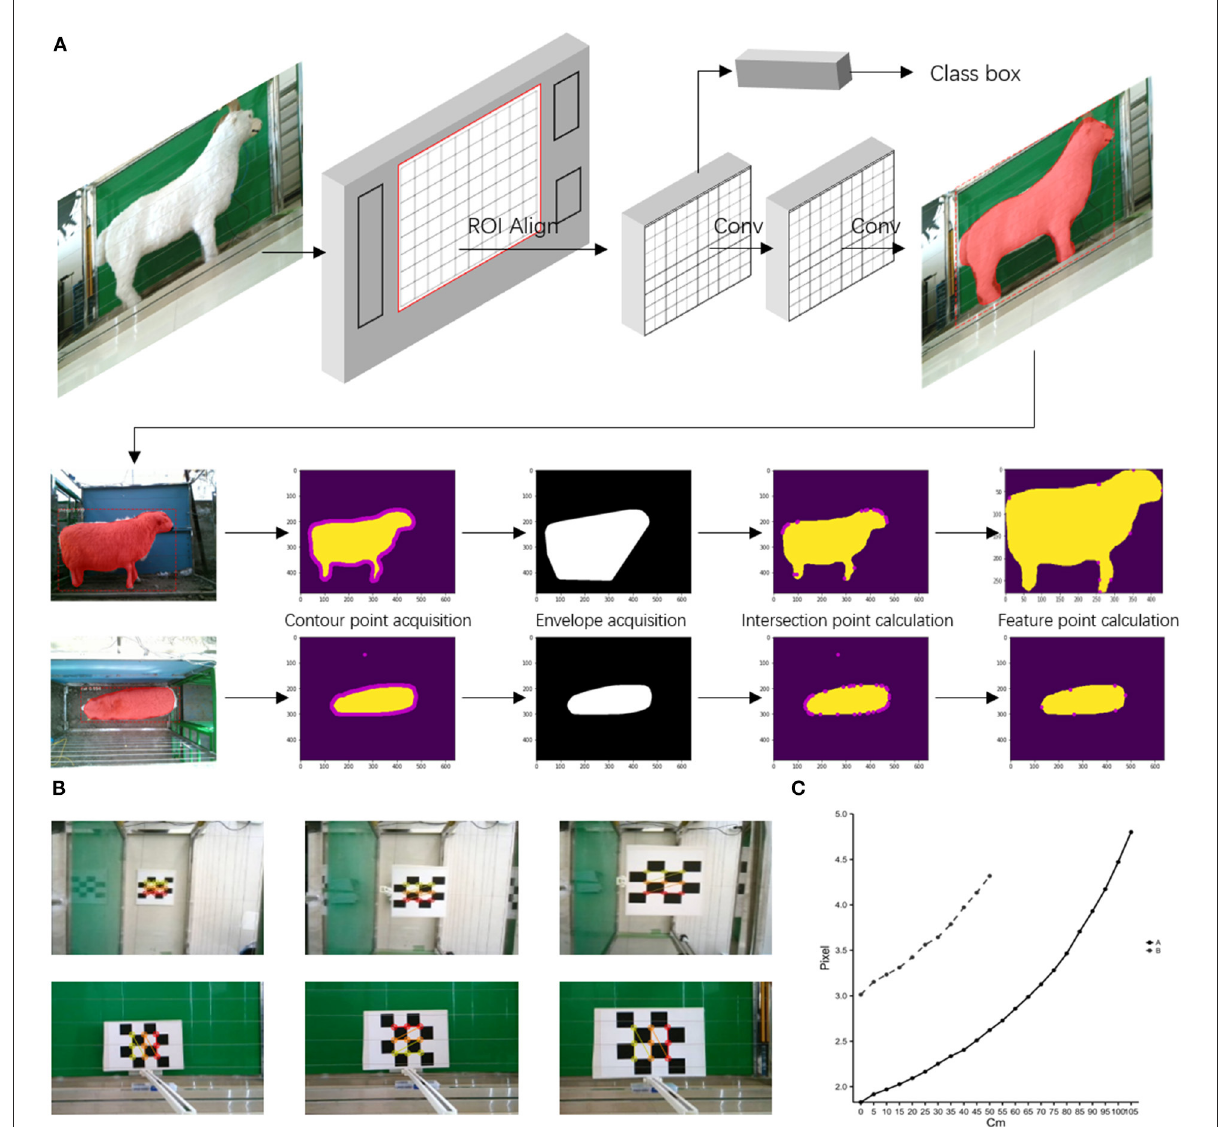
FIGURE5 Machine visual recognition flowchart and renderings. (A) Shows the flow chart of the Mask R-CNN to recognize the body size of sheep in a natural production environment, (B) shows the effect of the calibration plates at different distances, and (C) shows the pixel size relationship values per cm from the camera to the calibration plates at different distances, where the dashed line represents the side and the solid line represents the